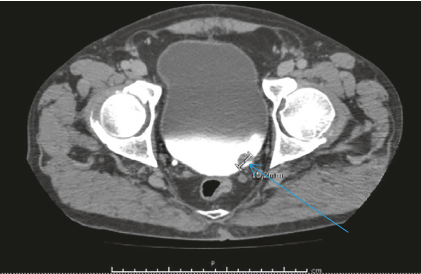
Figure 3: Sagittal section Uro-CTscan showing proliferative lesion left ureteral meatus